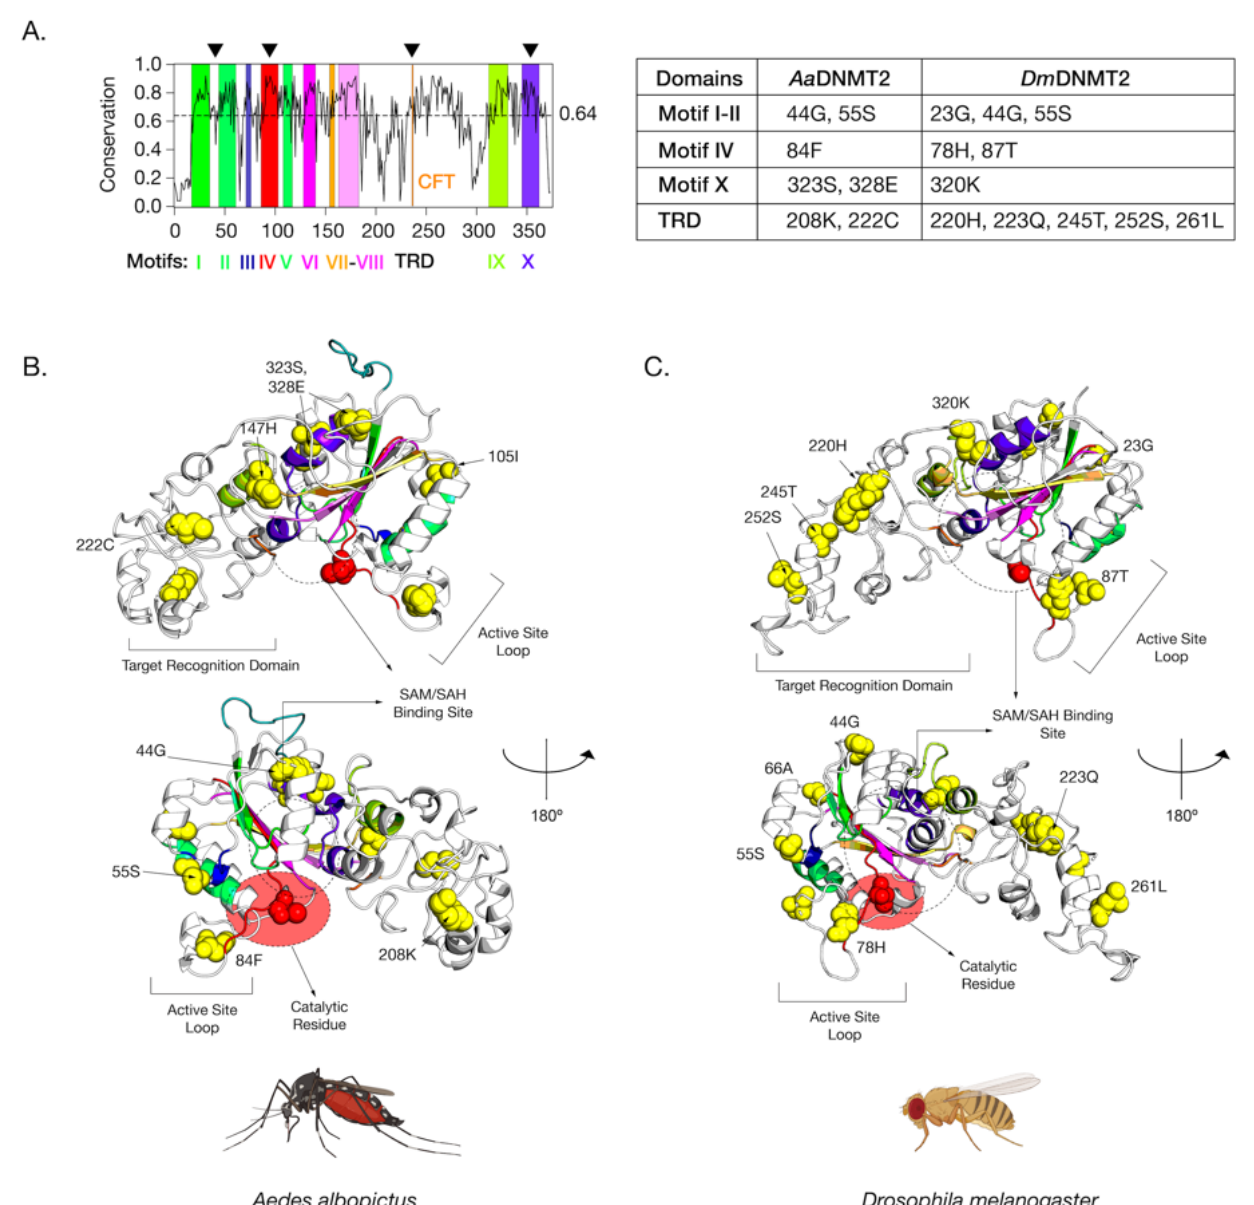
Figure 4. Amino acid positions in Drosophila melanogaster DNMT2 potentially under positive selection. ( A ) Shannon conservation plot representing the degree of conservation ( Y -axis) of DNMT2 orthologs present at every amino acid position ( X -axis) across within DNMT2 orthologs from mosquitoes and fruit flies. Colored boxes represent known DNMT2 functional motifs and domains involved in catalytic activity and target recognition (CFT). The mean conservation score (64%) across all amino acid positions is represented by the horizontal dotted line. Black arrows present on the top represent four major regions containing most amino acid positions with evidence of positive selection and high posterior probability values (>95%). These individual amino acids are also represented in the accompanying table to the right. ( B , C ) Spatial distribution of sites unique to each family is represented as yellow spheres on ribbon models of ( B ) Aedes albopictus (9 sites) and ( C ) Drosophila melanogaster (12 sites) DNMT2 structures visualized in PyMOL 2.4 (Schrödinger, LLC). The catalytically active cysteine residue (Cys, C ) is represented in red. The predicted substrate, i.e., S-adenosyl methionine (SAM) or S-adenosyl homocysteine (SAH), the binding region is shown as a dashed oval. Functionally important active site loop and target recognition domains are also indicated on each structure. The lower structures are rotated 180 ◦ relative to the upper ones around the vertical